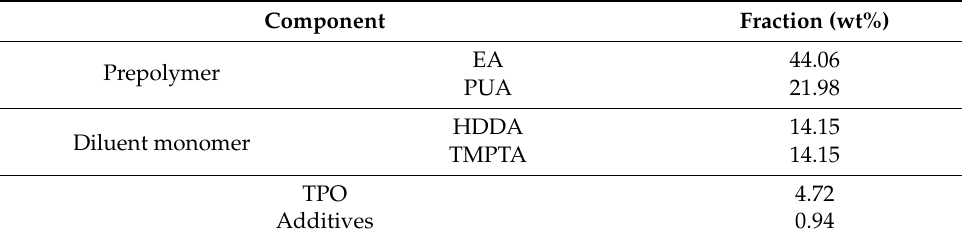
Table 1. The formula of photocurable